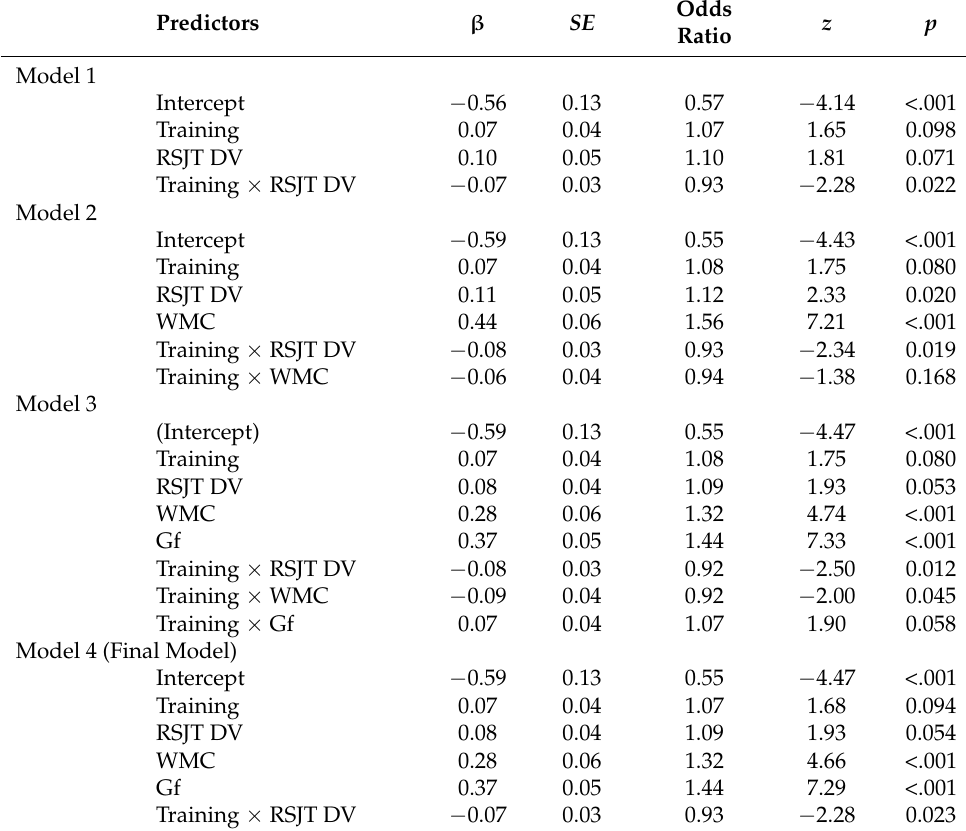
Table 3. Predicting figural analogy accuracy with RSJT different-version scores, WMC, and Gf. Predictors β SE